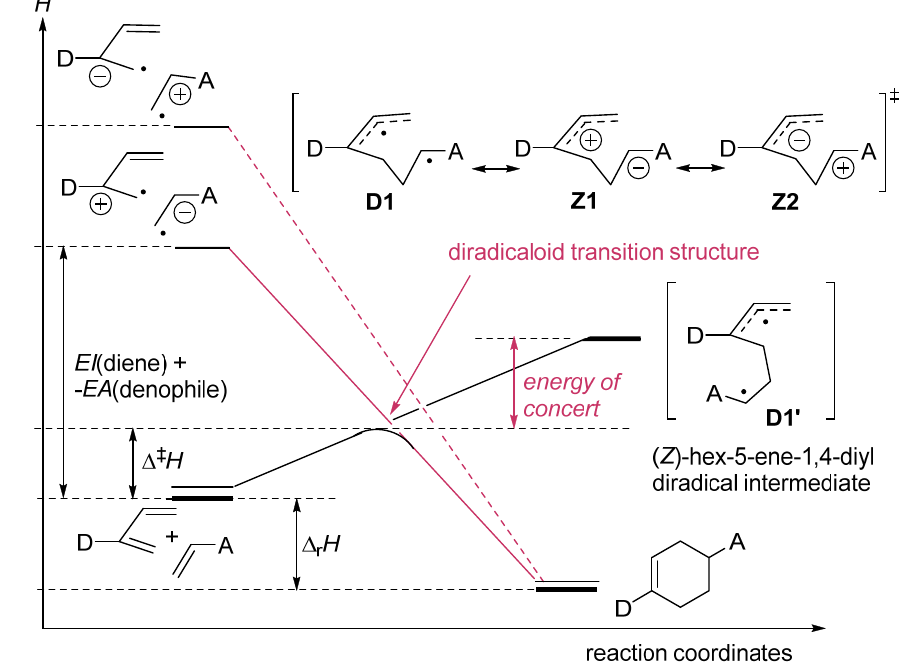
Figure 3. The valence-bond diradicaloid model for transition states of concerted Diels–Alder reactions. The lower is the sum EI (diene) + ( − EA (dienophile)), or EI (dienophile) + ( − EA (diene)); the faster is the cycloaddition; the higher is the degree of concert.